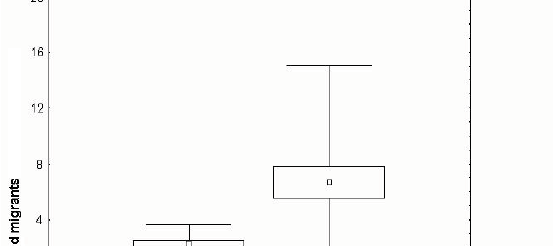
Figure 3. Box-plot showing a mortality rate among offspring (OP) of non-inbred (non-inbred OP) marriages in comparison with inbred marriages (inbred OP). Rs=0.28. t=2.98.